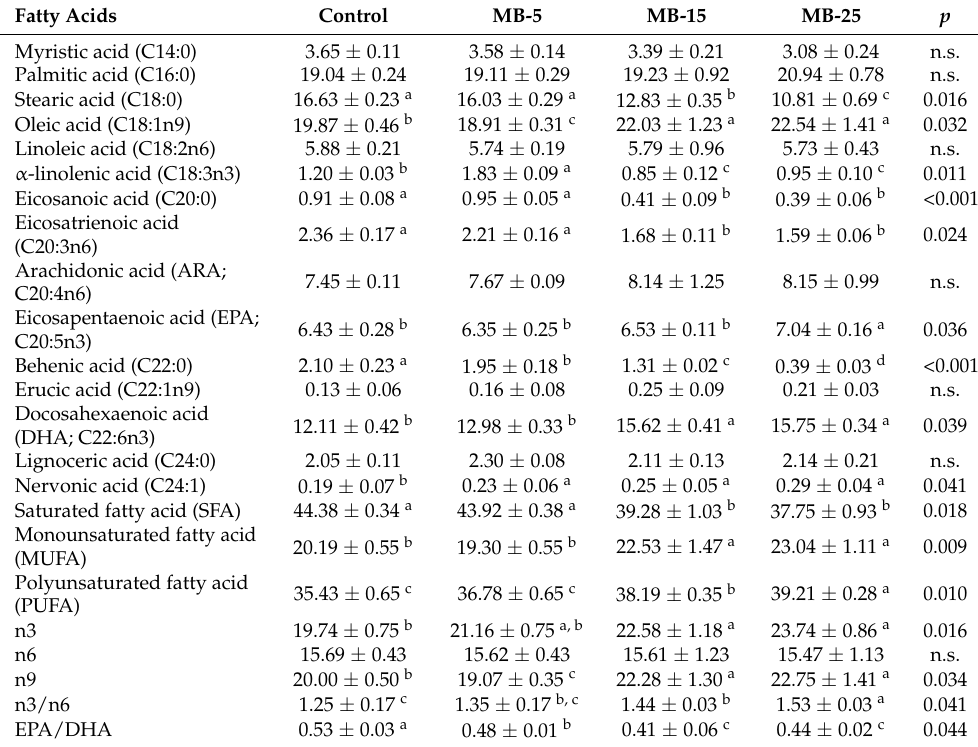
Table 5. Liver fatty acid composition (% fatty acids) of juvenile S. aurata fed experimental diets for 30 days. Fatty Acids Control MB-5